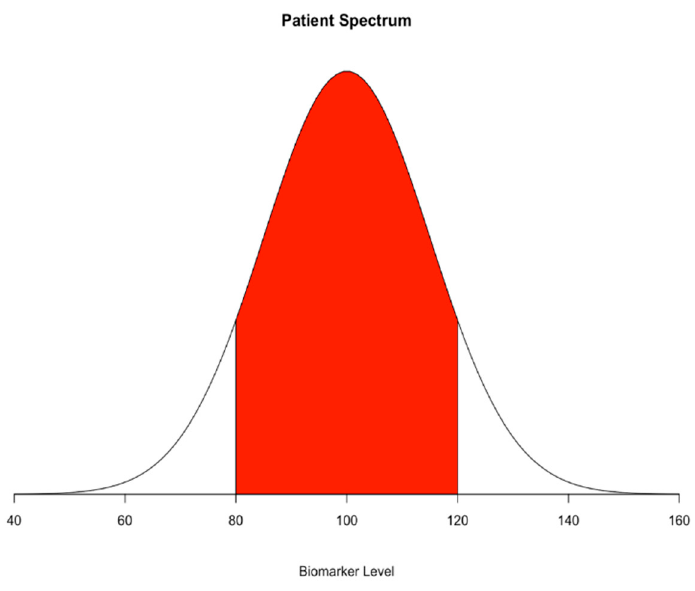
Figure 2. Patient spectrum in case-control studies. Red area indicates the not included